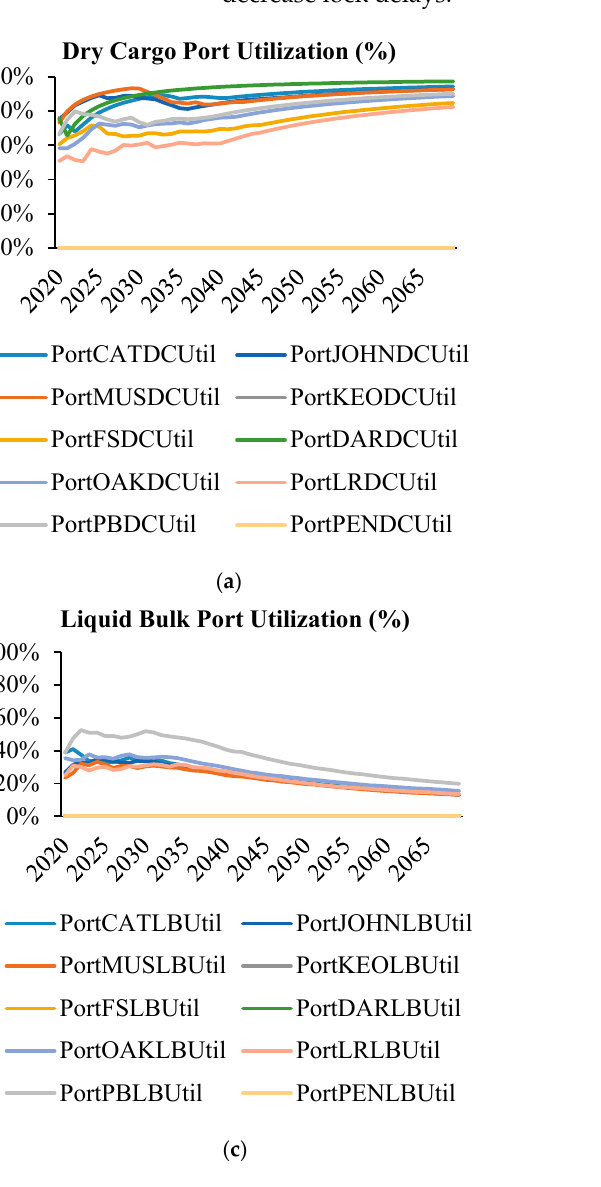
Figure 3. MKARNS port utilization by commodity type.